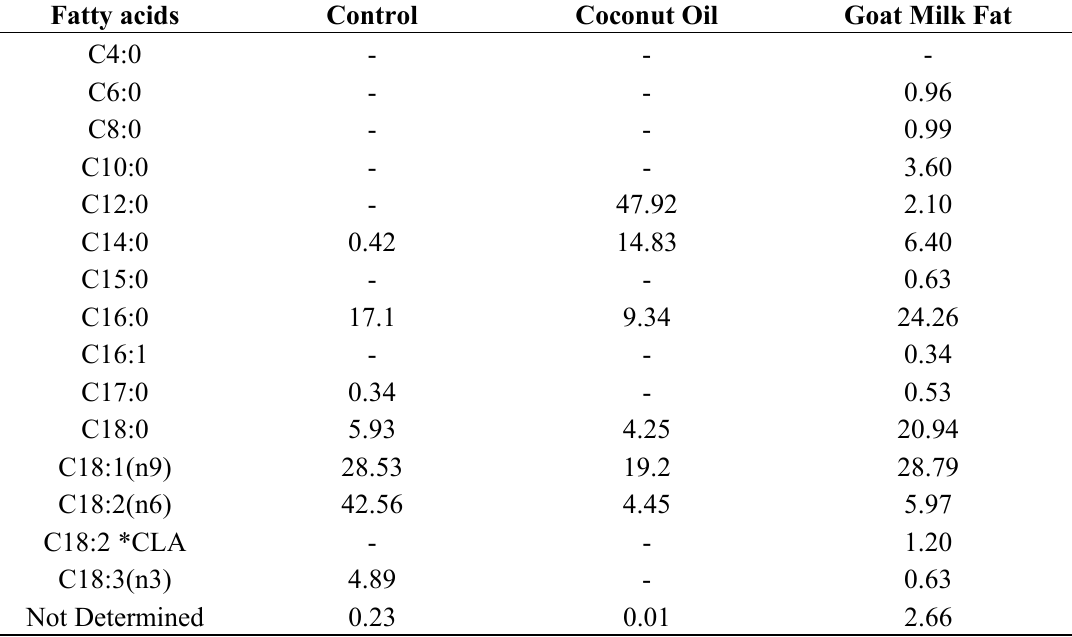
Table 2. Fatty acid profile of the different fat sources